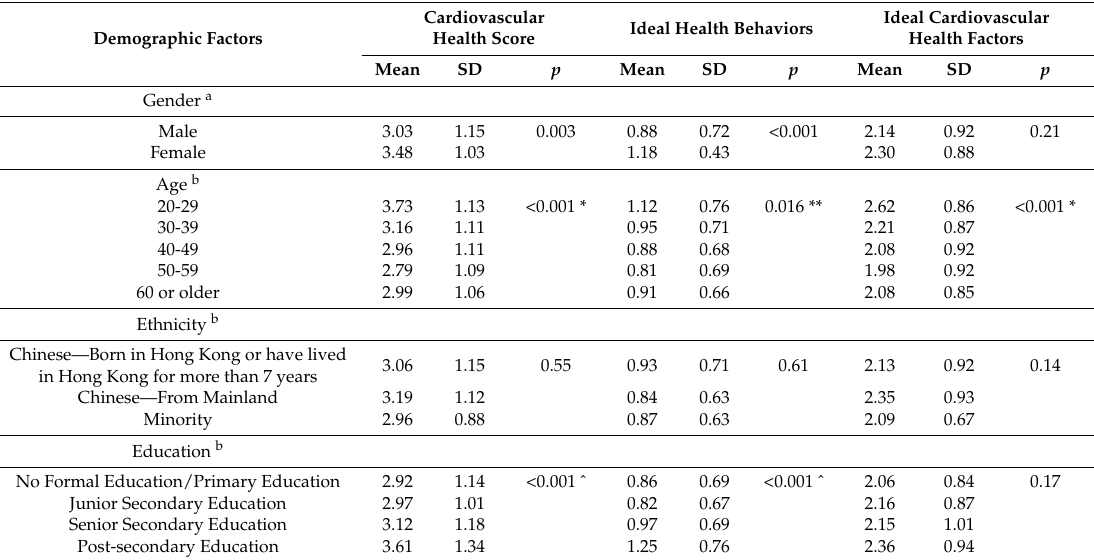
Table 4. Overall cardiovascular